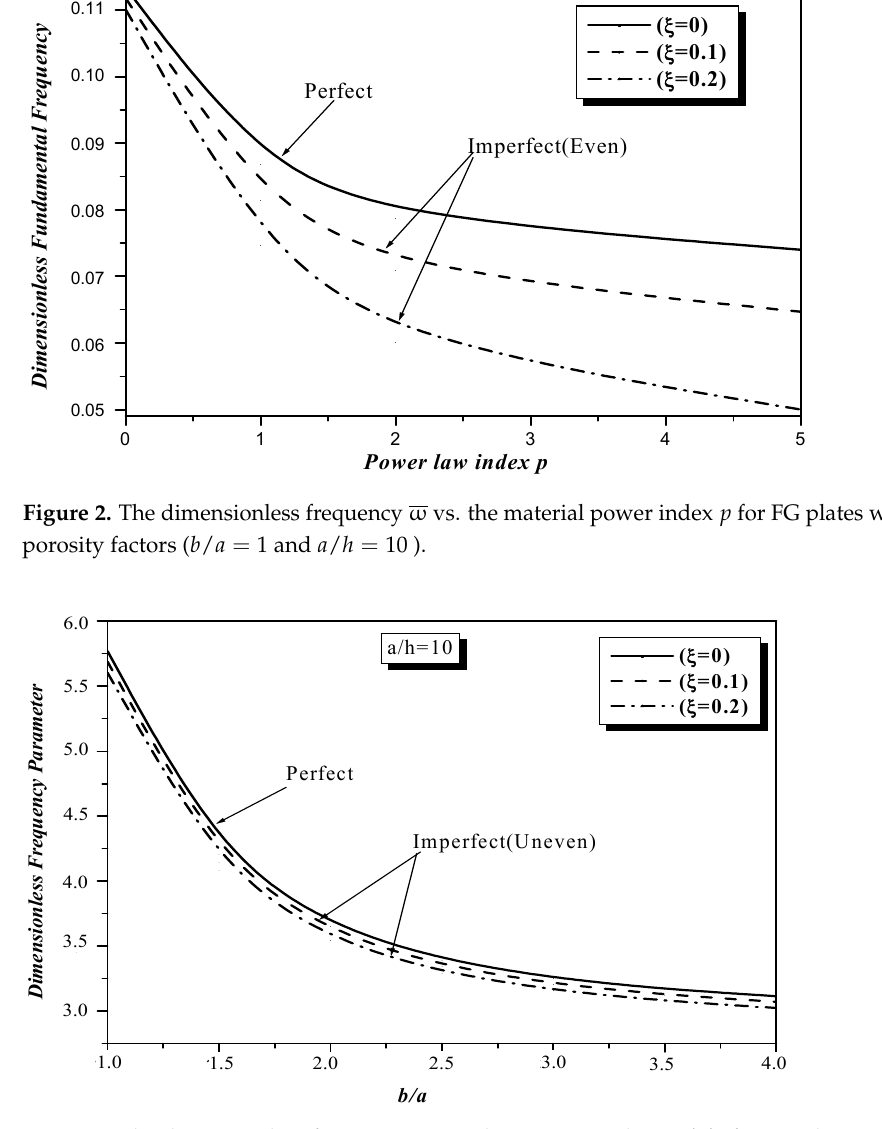
Figure 3. The dimensionless frequency ω vs. the geometrical ratio b / a for FG plates with different porosity factors.